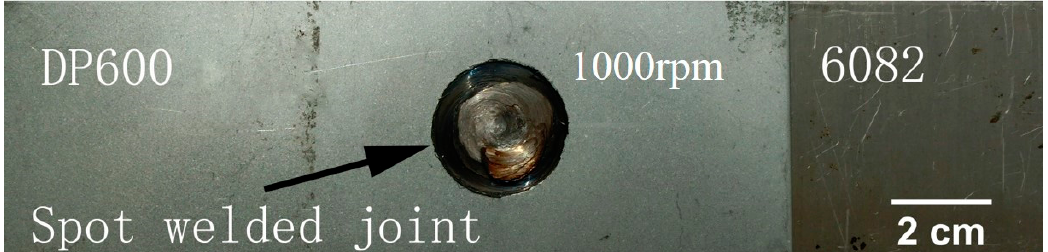
Figure 5. Sample of a dissimilar Al/steel keyhole-free FSSW joint.